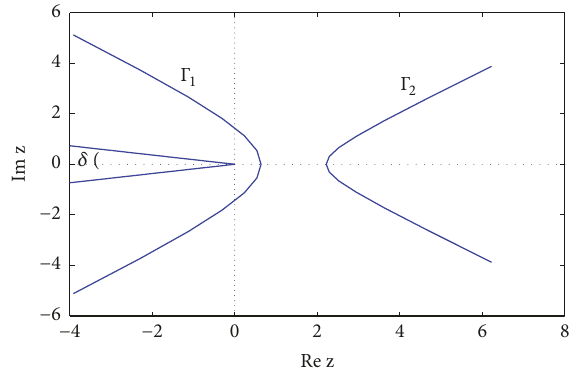
Figure 1: An example of Hankel contours.